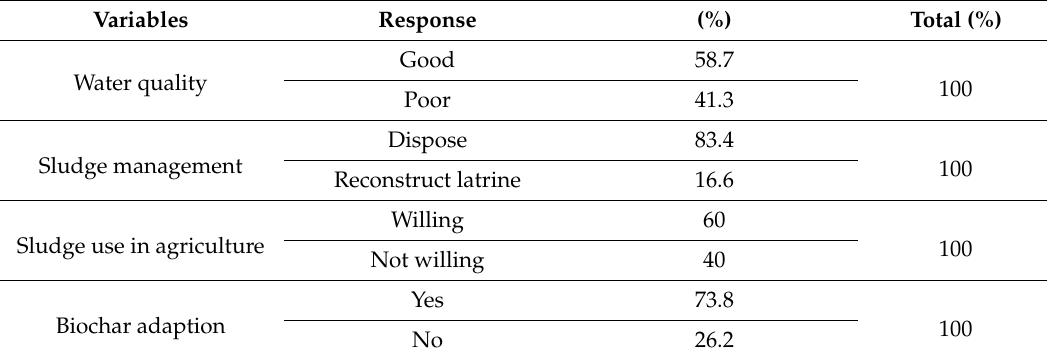
Table 2. Socio-economic predictor variables characteristic in the